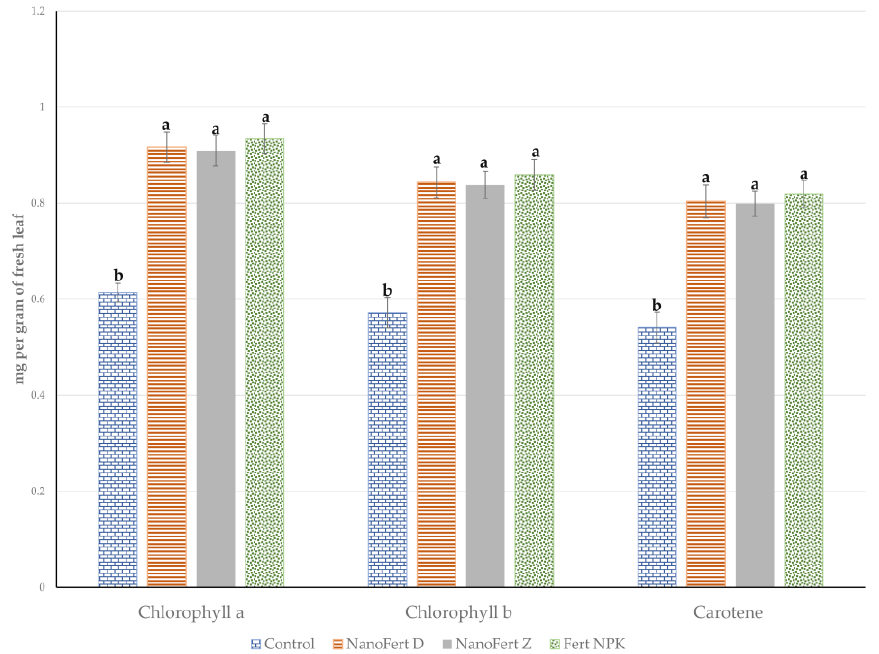
Figure 3. The effects of the experimental treatment with foliar fertilizers and foliar fertilizers with particle film-forming SNNMs on the photosynthetic pigments of the leaves from the apple trees. Orchard of “Vasili Adamachi” experimental farm, Faculty of Horticulture, “Ion Ionescu de la Brad” Iasi University of Life Sciences, 2022. Values followed by the same letter do not differ significantly at p < 0.05.